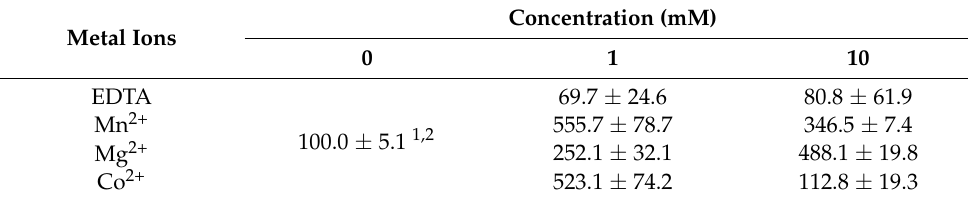
Table 1. Effect of metal ions on the L -fuculose-isomerizing activity of L -fucose isomerase ( L -FucI) from Halothermothrix orenii ( Ho FucI) 1